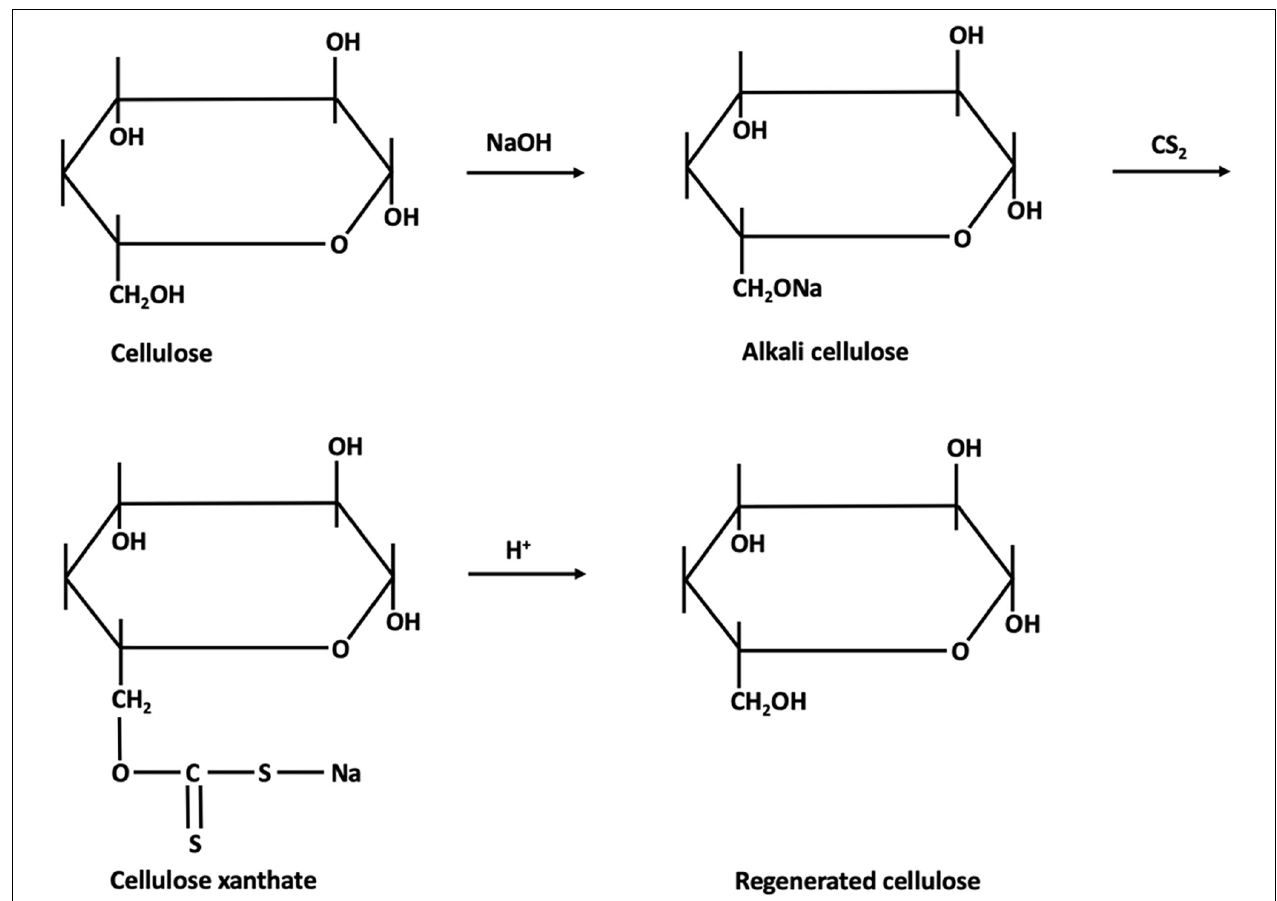
FIGURE 4 | Mechanism of Viscose fiber production [addapted from McKeen (2017), Rodgers and Waddell